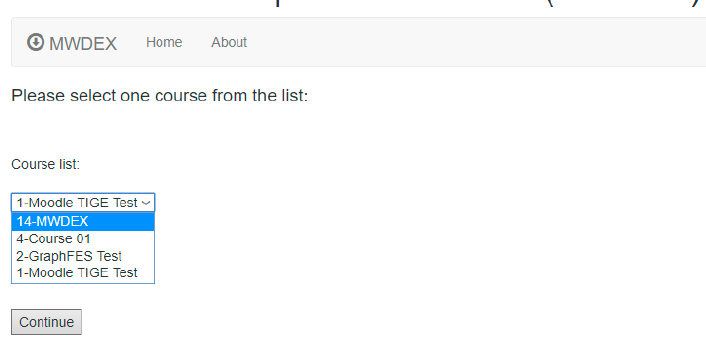
Figure 5. MWDEX screen for course selection.